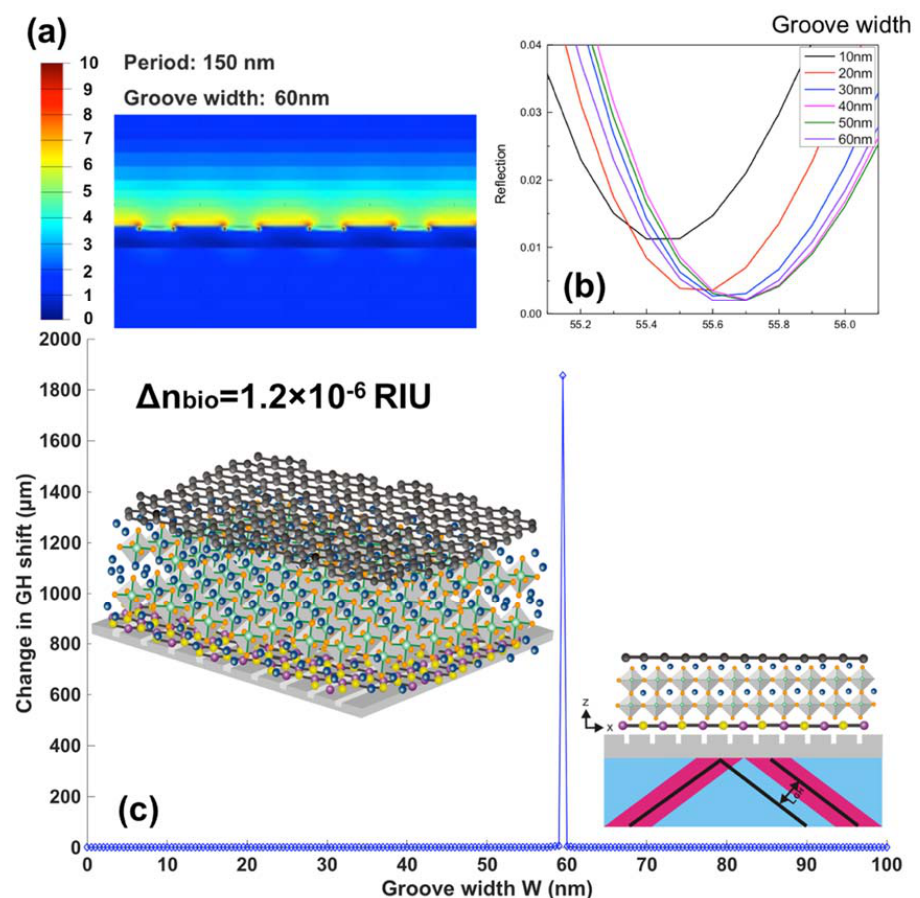
Figure 10. ( a ) Electric field distribution of 2D perovskite-based metasurface patterns under the SPR excitation condition; SPR curves with ( b ) Reflectivity and GH ( c ) signal changes tuned by the groove width of the metasurface structure.